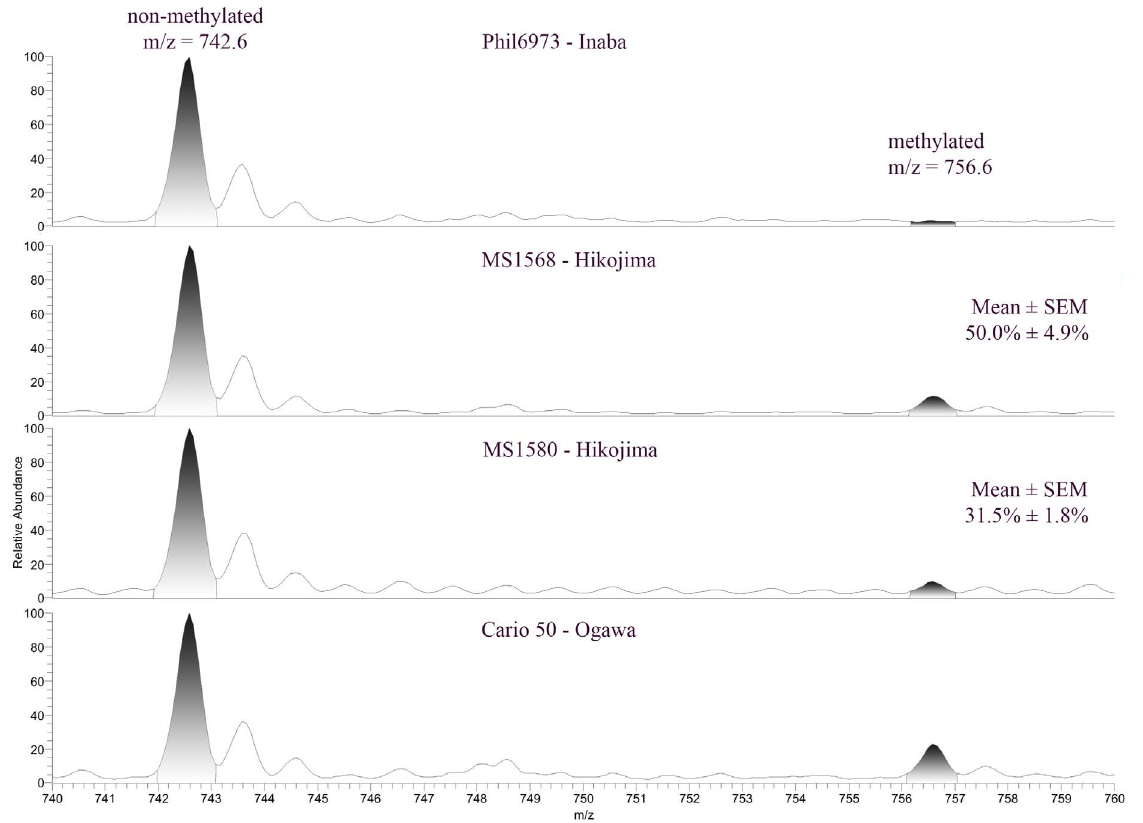
Figure 3. Determinations of the relative amounts of Ogawa antigen in LPS preparations of the generated Hikojima strains MS1568 and MS1580 based on amounts of methylated and un–methylated perosamine analyzed with mass spectrometry in relation to similar analyses of LPS preparations from reference Inaba Phil6973 and Ogawa Cairo 50 strains. The area under the curve for the methylated part (m/z ratio 756.6) divided by the area under the curve for the non–methylated part (m/z ratio 742.6) subtracted with the background (this ratio from the Inaba strain Phil6973) was used for the two Hikojima strain (MS1568 and MS1580) LPS preparations to calculate their percentage of Ogawa LPS (compared to the 100% Ogawa in the LPS from the Cairo50 reference strain). Diagrams are from one of 3 such experiments showing closely similar patterns and with the calculated mean 6 SEM percentages Ogawa antigen indicated for MS1568 and MS1580.